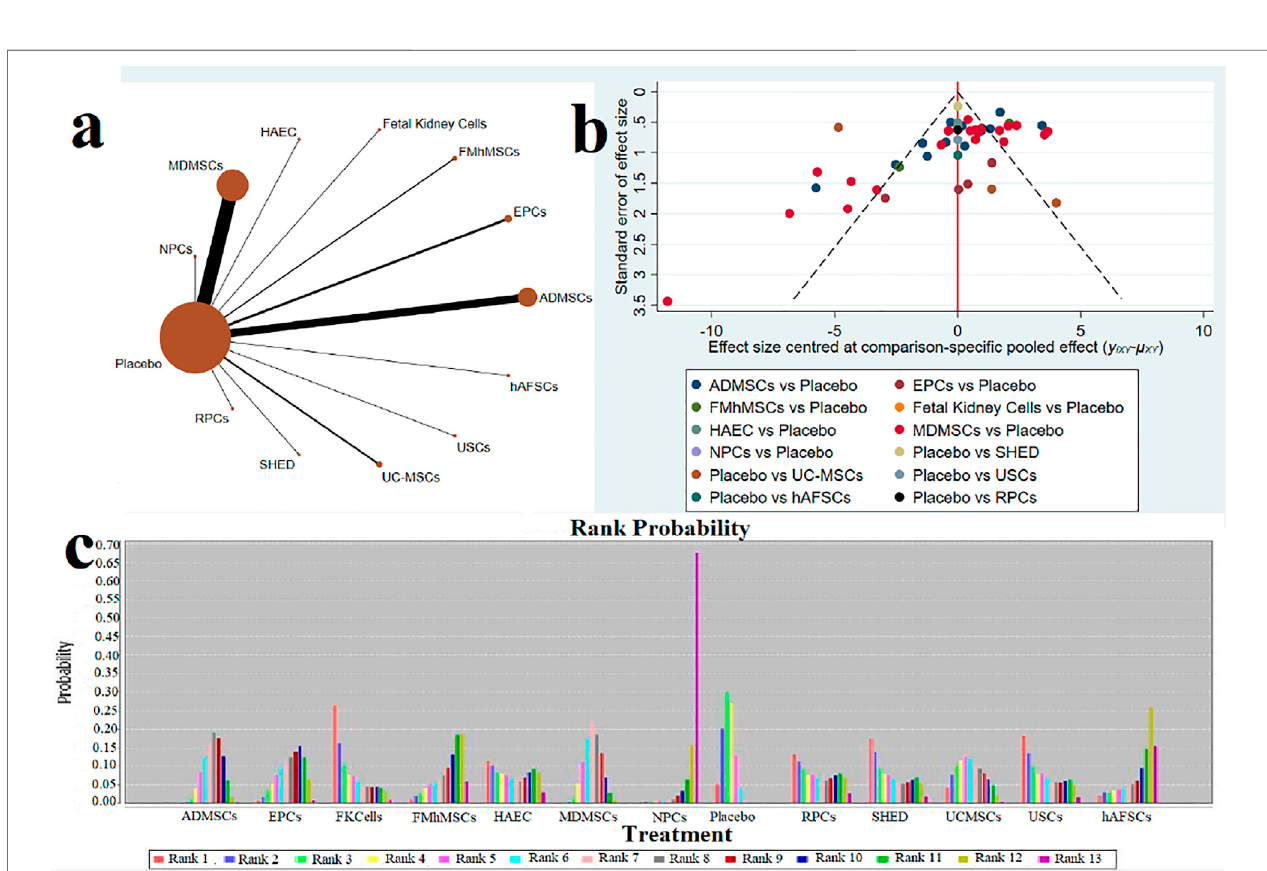
FIGURE 3 | Network Meta-analysis of serum creatinine levels at 1 day after administration (A) Evidence network diagram; (B) The comparison-correction funnel plot; (C) The ranking results).